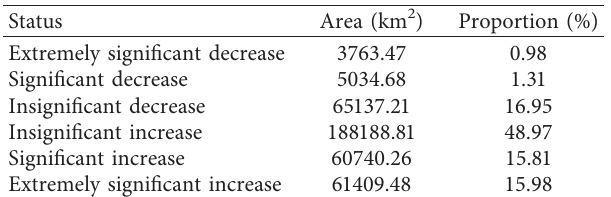
Table 3: Statistics of NDVI trends in the Yunnan Province